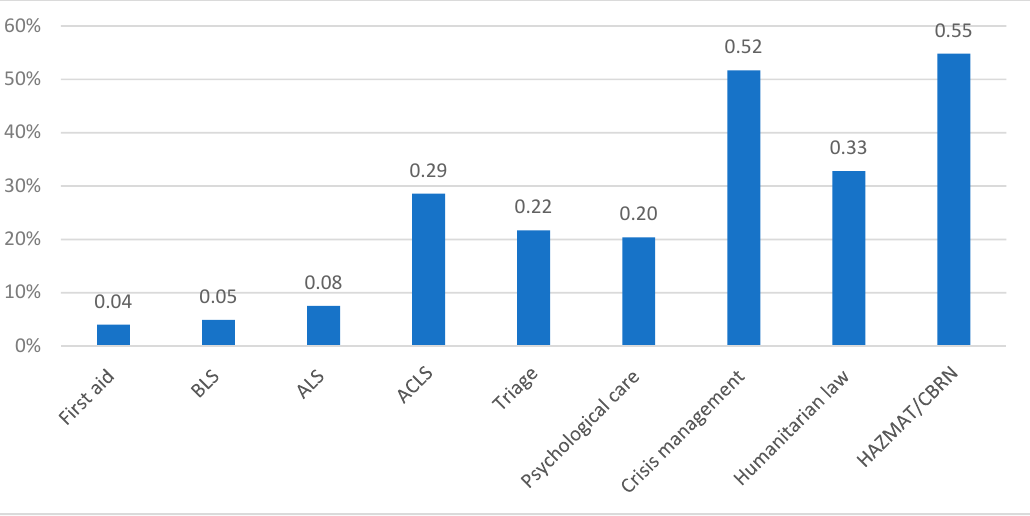
Figure 1. The distribution of preferences for specific training.